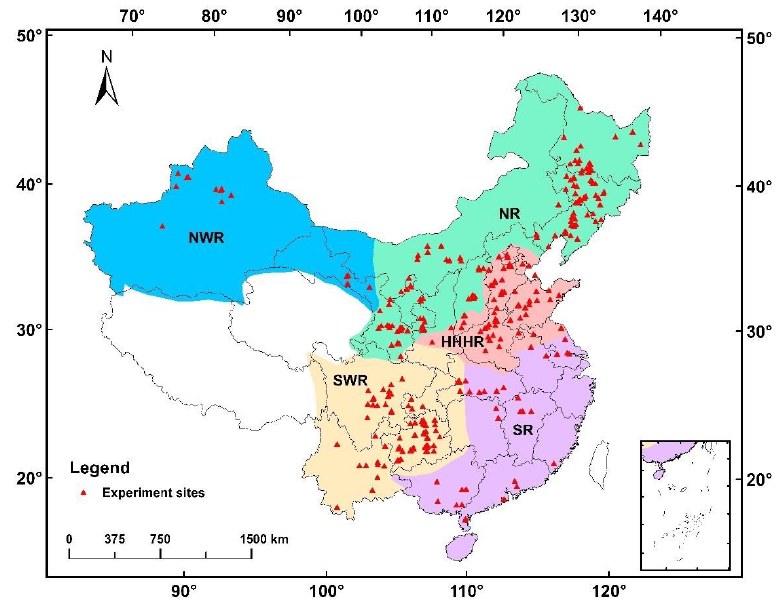
Figure 1. The locations of the five maize-growing regions of China. NR: Northern region; HHHR: Huang-Huai-Hai region; SR: Southern region; SWR: Southwestern region; NWR: Northwestern region. The triangles represent the locations of the trials that were included in the meta-analysis. The data were sourced from the China Knowledge Resource Integrated Database (https://www.cnki.net/old/ (accessed on 10-20 October 2020)) and Web of Science (http://www.apps.webofknowledge.com/ (accessed on 23 October 2020)) regarding studies that were conducted between 2005 and 2018. Table 1. Sowing period, harvest period, meteorological conditions, and soil properties of each maize-growing region in China. The data were sourced from the China Knowledge Resource Integrated Database (https://www.cnki.net/old/ (accessed on 25 October 2020)) and Web of Science (http://www.apps.webofknowledge.com/ (accessed on 25 October 2020)) regarding studies that were conducted between 2005 and 2018.